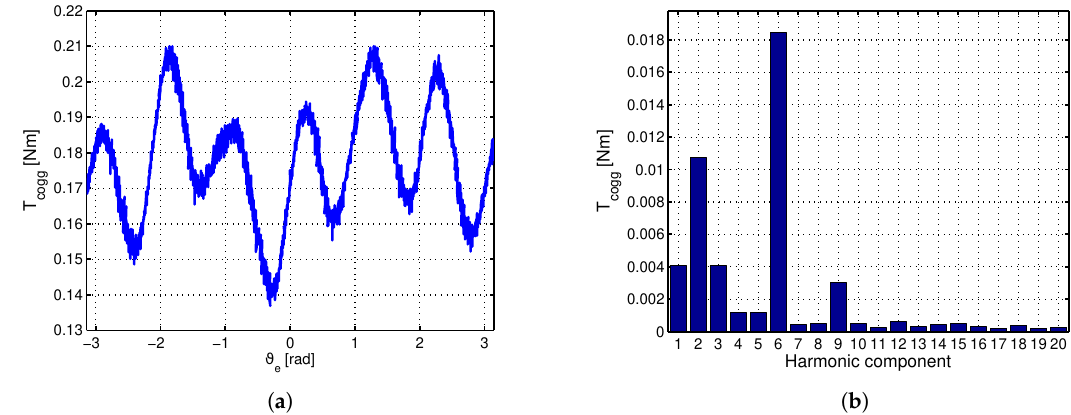
Figure 5. ( a ) Measured cogging torque at 45% of rated load ( b ) FFT analysis of measured cogging